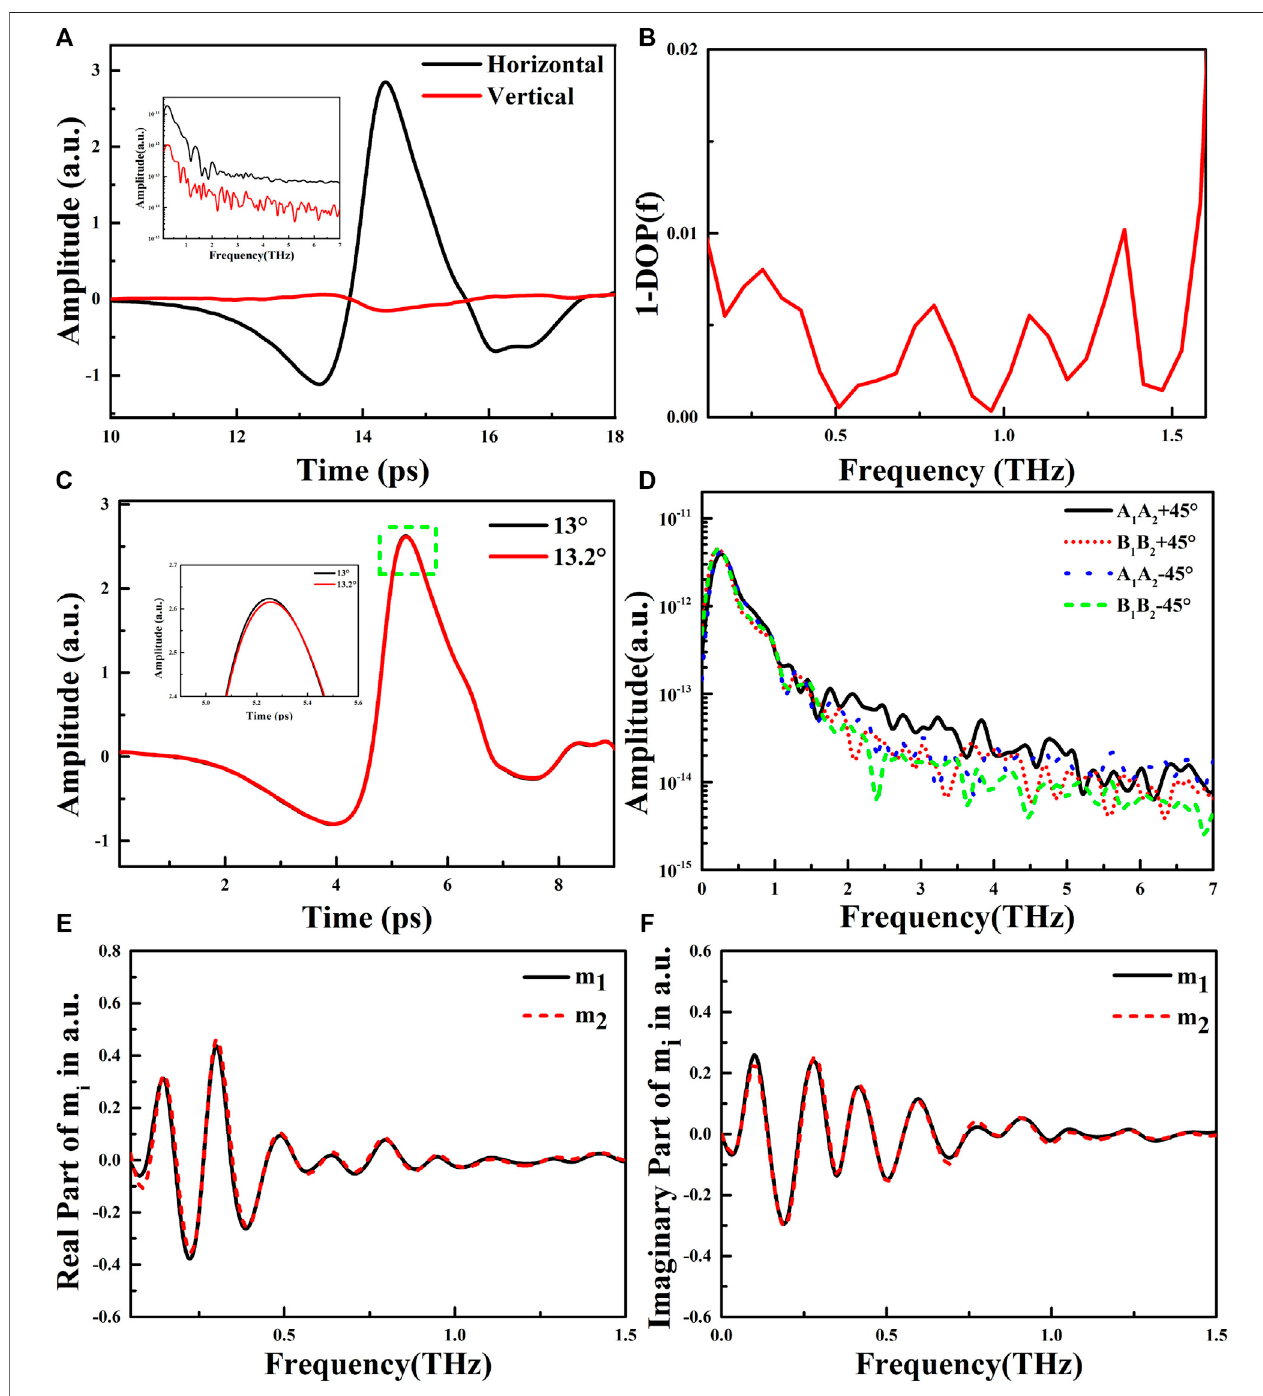
FIGURE5| At θ =0 ° (A) ThehorizontalandverticalTHzelectric fi eldofthephotoconductiveantennaarraydetectorand (B) Experimental measurementofDOP (C) Response accuracy of photoconductive antenna array to polarized THz electric fi eld at θ = 13 ° (D) The frequency spectrum corresponding to the dual-channel signal of thephotoconductivedetectionantennaarrayat θ = +/-45 ° ;Therelationshipbetweentherealpart (E) andimaginarypart (F) oftheresponsematrixfactors m 1 and m 2 with frequency.